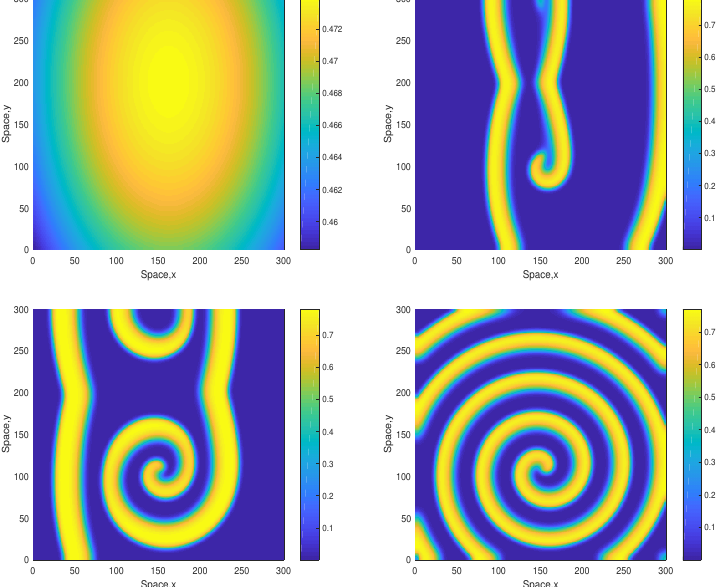
Figure 5. Spatial distribution of the oxygen concentration obtained for A = 2.4 and shown for t = 1, t = 120, t = 200 and t = 1200 (left to right, top to bottom). Other parameters are the same as above. The initial conditions are given by Equations (13)–(15) with c 0 = 0.4723, u 0 = 0.3612 and v 0 = 0.1554.